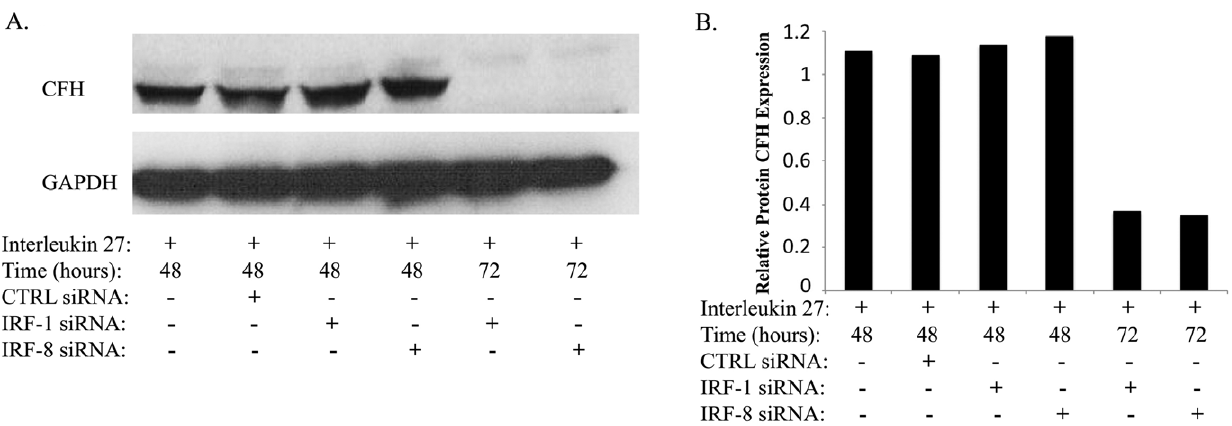
Figure 4. siRNA-mediated silencing of IRF-1 or IRF-8 abrogated the induction of CFH by IL-27. ARPE-19 cells were stimulated with human IL-27 in the presence or absence of control siRNA, IRF-1 siRNA or IRF-8 siRNA. (A) Detection of CFH expression by Western blot analysis. (B) Blots were analyzed and relative levels of CFH protein were quantified by densitometry; samples were normalized to the GAPDH expression level.